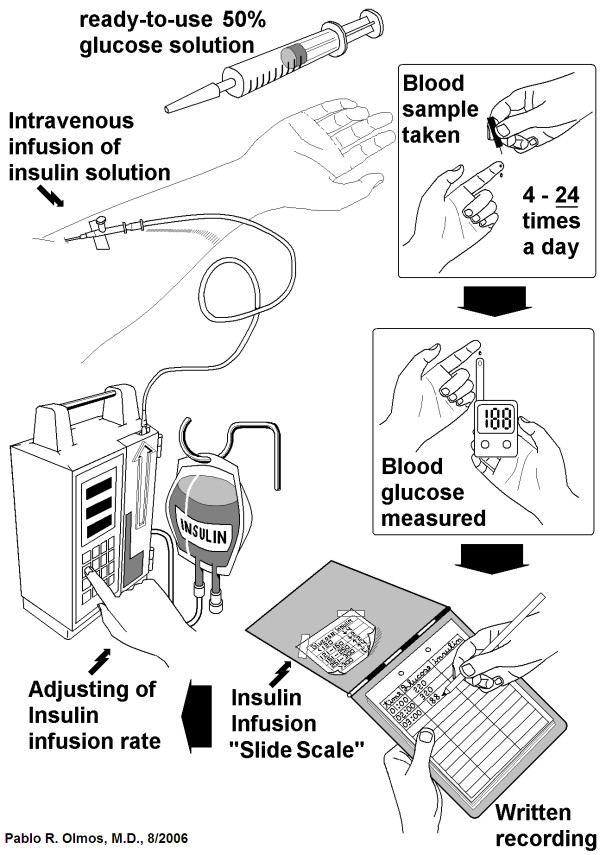
Current in-patient management of intravenous insulin infusion. Current in-patient management of intravenous insulin infusion(see text) Nurses have to measure capillary blood glucose every 1-6 hours, and after manually recording date, time and value, they read a "slide scale" previously estimated by the attending physician, that helps them to adjust the insulin infusion rate for the next period.